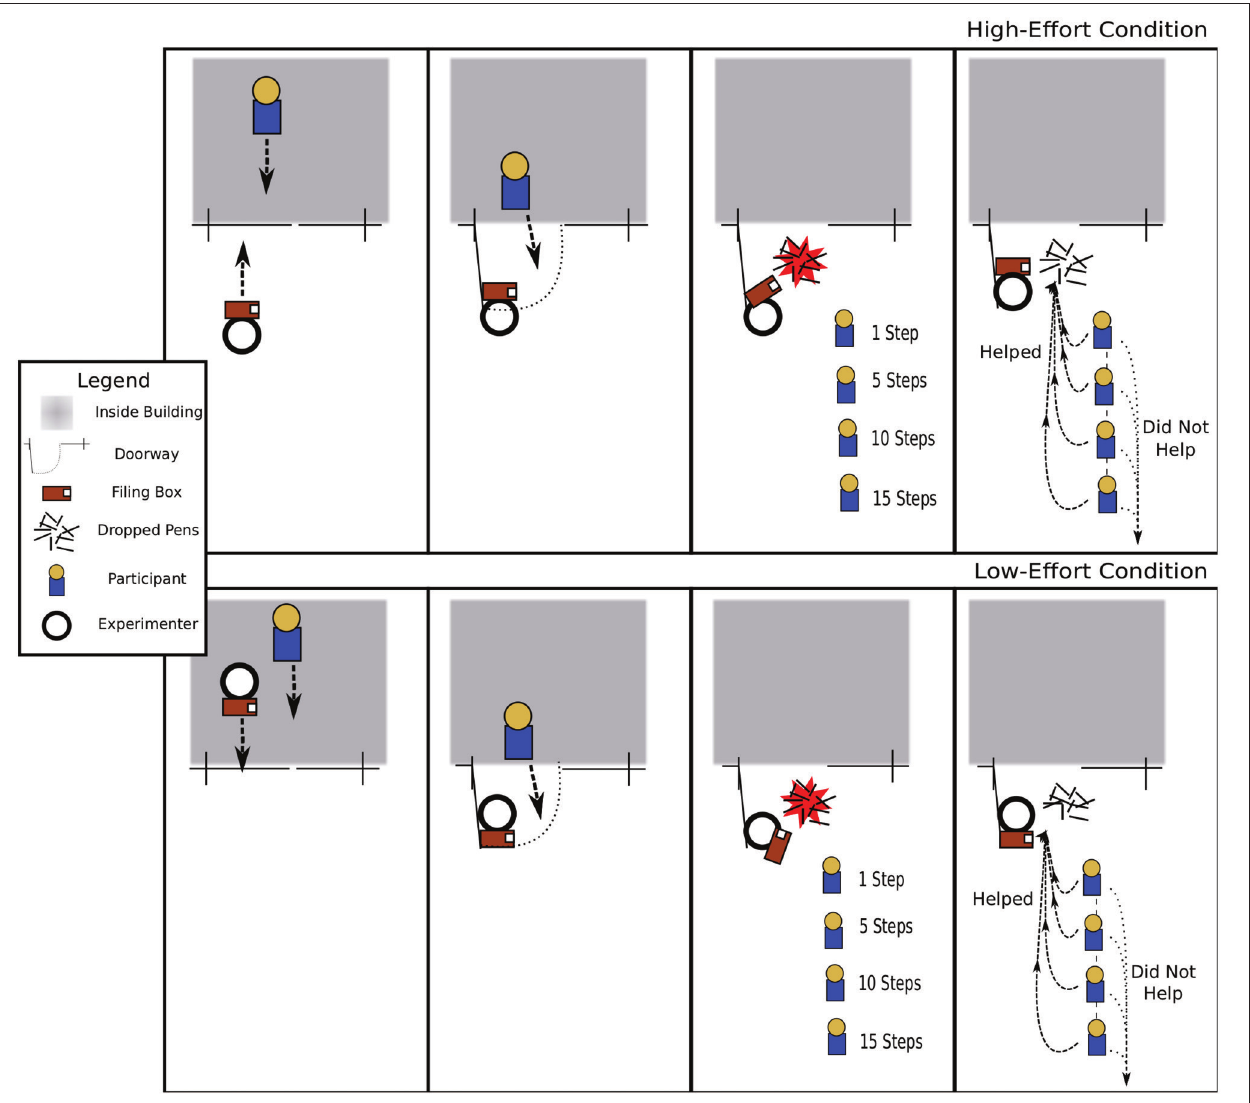
FIGURE 2 | Depiction of how trials were conducted in Study II. The panels depict the steps for a trial in the low- and high-effort conditions, respectively, moving left to right.